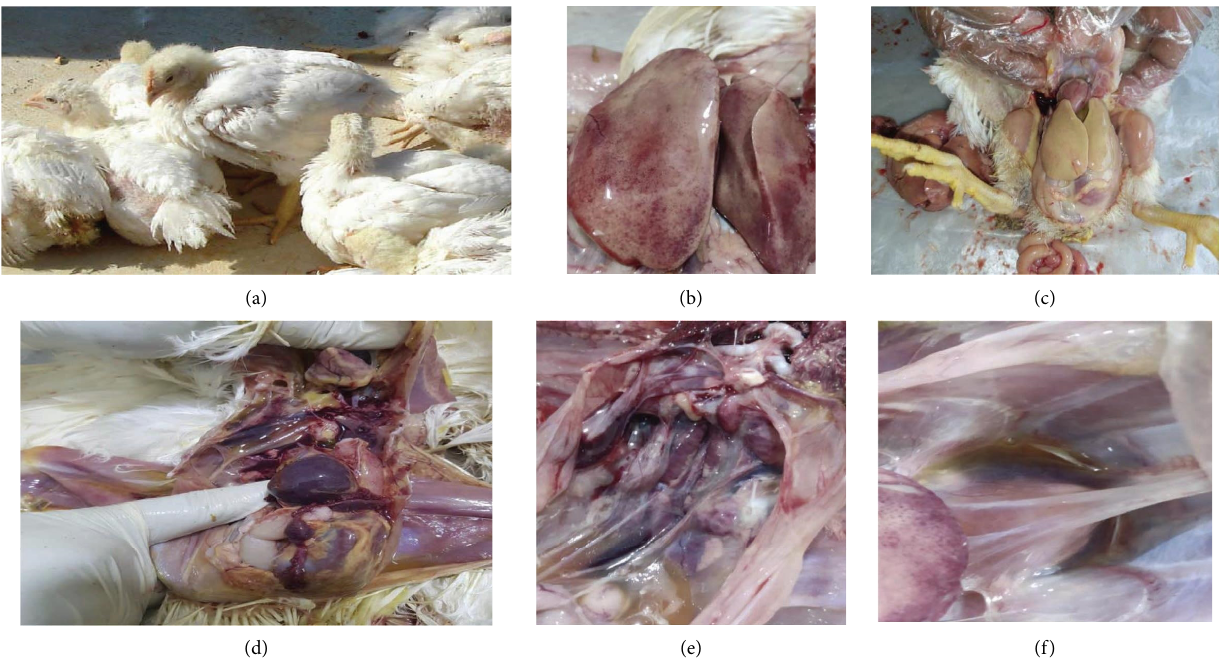
Figure 2: Clinical signs and postmortem lesions of chicken infected with fowl adenoviruses. (a) Depression, rufed feather & reluctant to move of 1.3wks broiler breeder, (b) hemorrhagic, pale and enlarged liver of 7days old broiler, (c) tan colored liver of 7days old broiler, (d) swollen and congested spleen of 15days old broiler breeder, (e) swollen and hemorrhagic kidney of 10days old broiler breeder, and (f) hydropericardium of 12days old broiler.